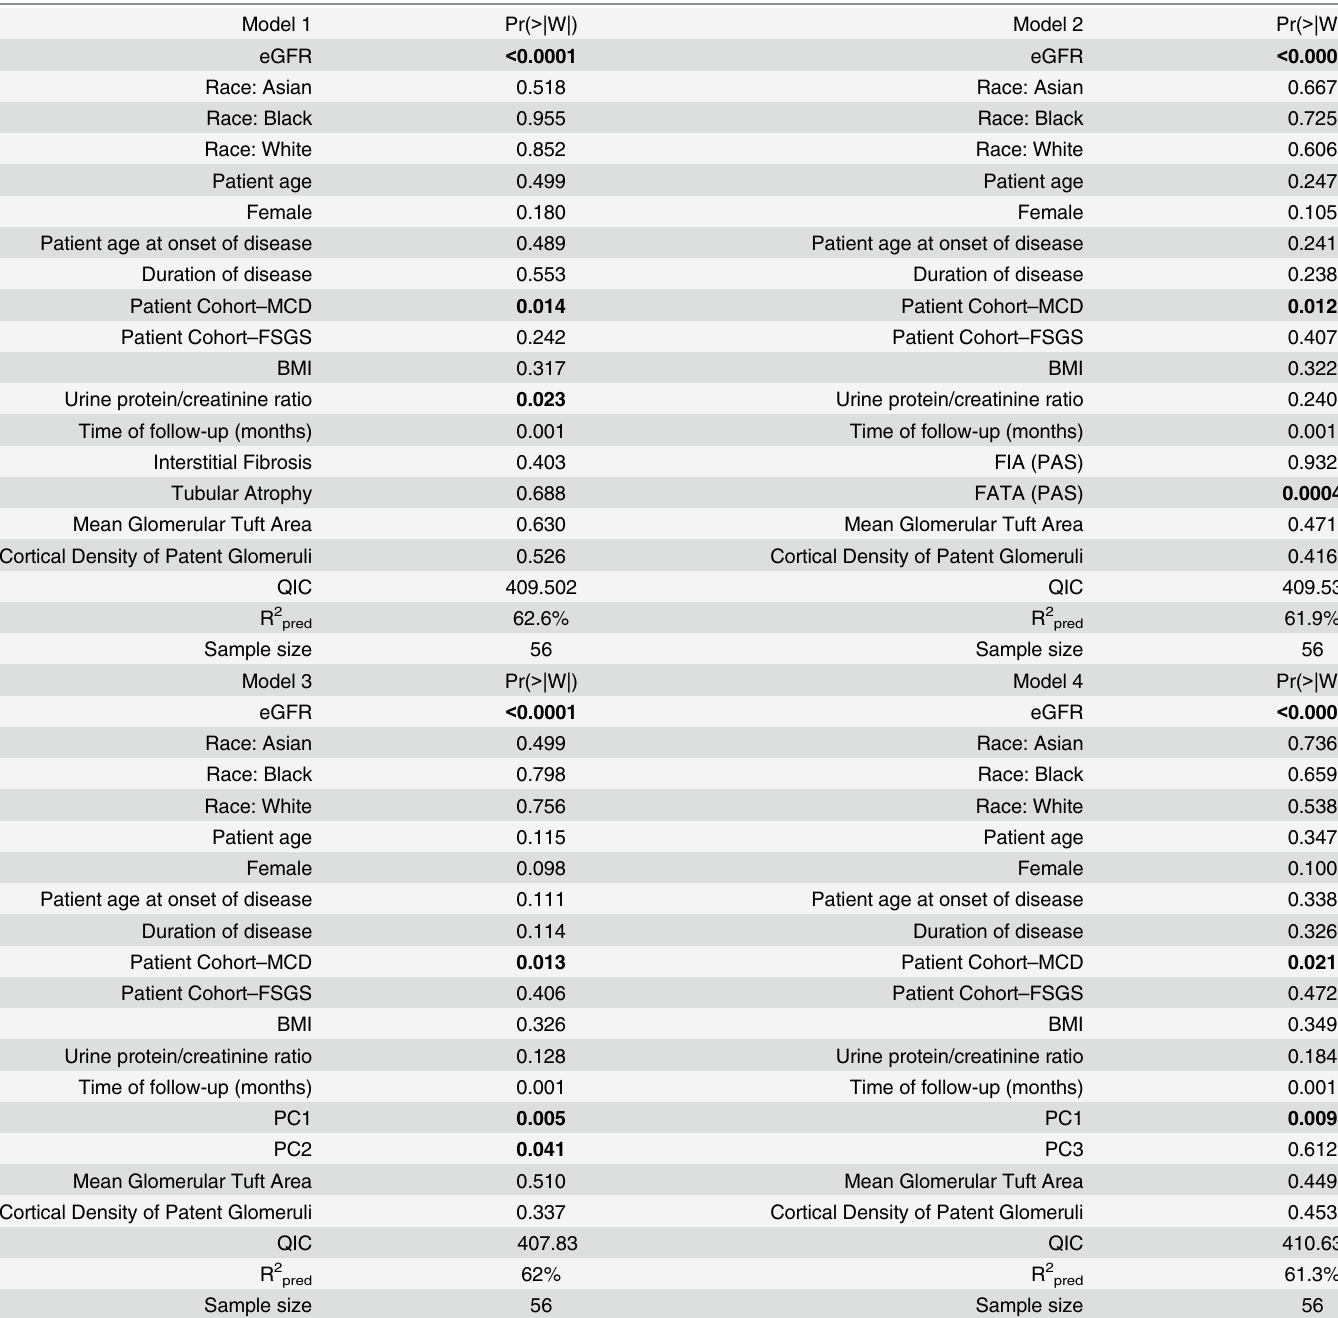
Table 3. Four generalized estimating equation models based on 13 baseline clinical/demographic and 4 structural variables per model. Pr( > |W|) represents the Wald statistic of the model